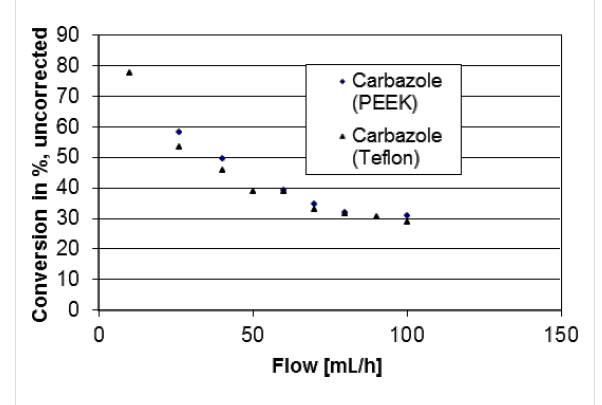
Figure 3: Carbazole synthesis in miniaturized photoreactors Type II (PEEK and Teflon), flow control, P = 0.92 W.